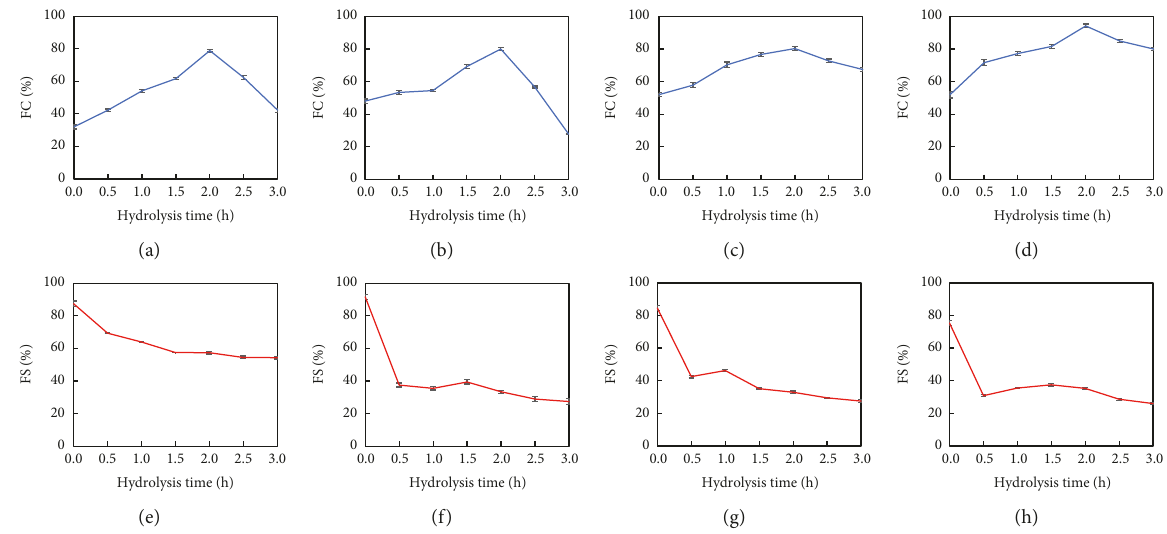
Figure 8: FC and FS analysis of (a & e) nonextruded, (b & f) Ex60-HSPP, (c & g) Ex80-HSPP, and (d & h)